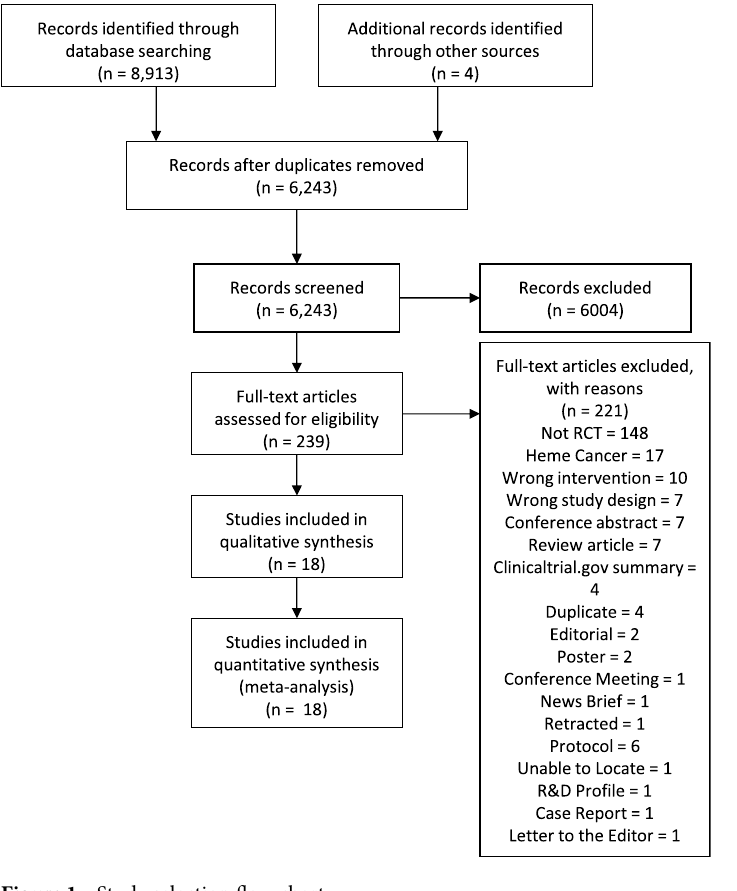
Figure 1. Study selection flow